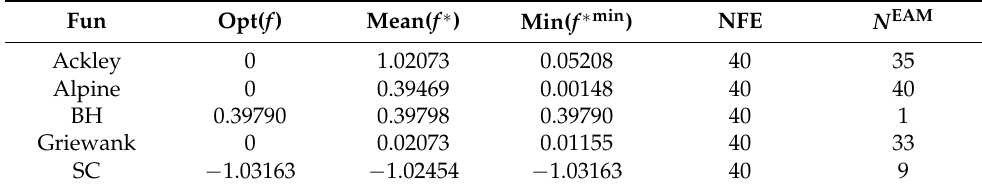
Table 1. The result on five